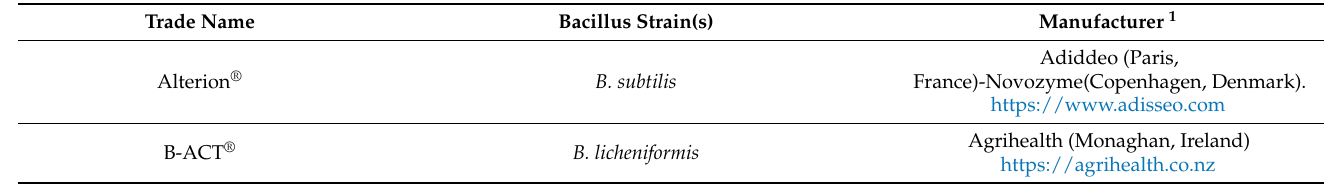
Table 1. Non-comprehensive list of commercially available Bacillus -based probiotics used in poultry production. Trade